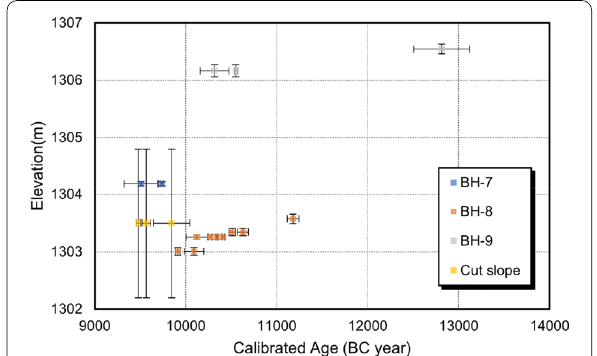
Fig. 11 Relation diagram between calibrated age and elevation of organic soil